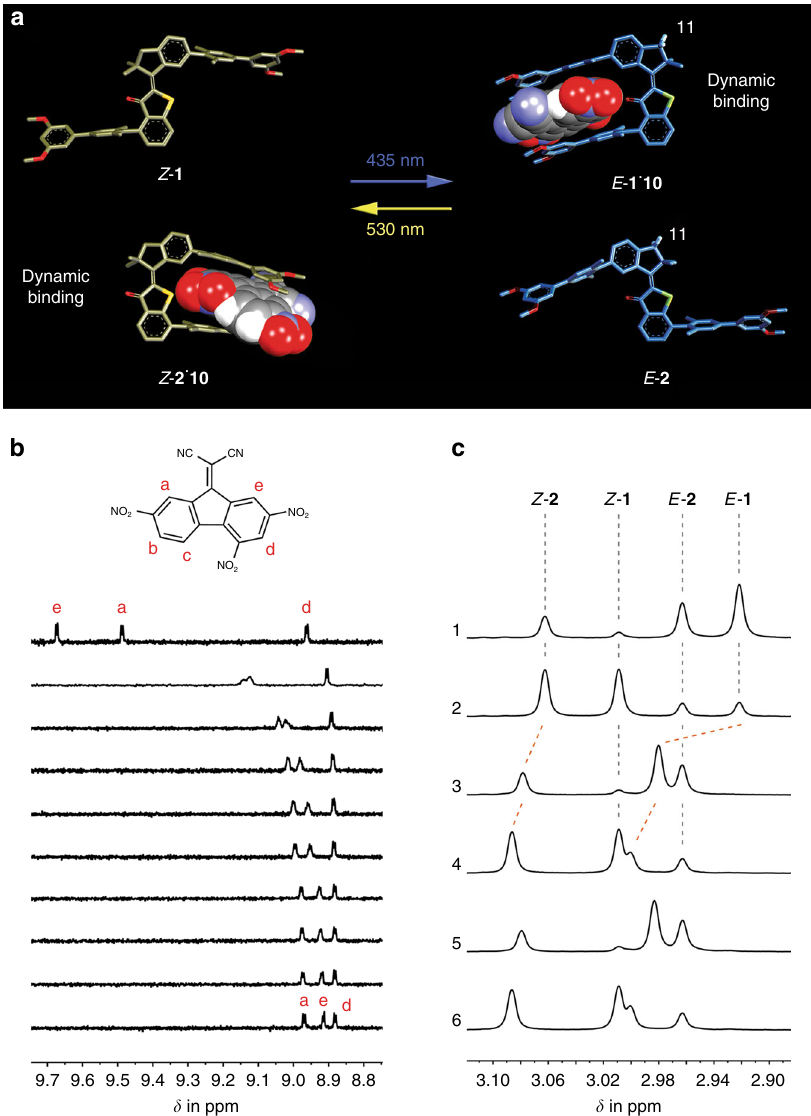
Fig. 5 Simultaneous photoswitching controls dynamic guest relocalization. a The molecular structures of tweezers 1 and 2 in different isomeric states, as well as their supramolecular complexes E - 1 . 10 and Z - 2 . 10 were obtained from quantum chemical modeling at the B3LYP/6-311 G(d,p) or B3LYP-GD3BJ/6- 311 G(d,p) level of theory, respectively. b Selected region of the 1 H NMR (400 MHz, 253 K, CDCl 3 ) spectra acquired during titration of 10 with E - 1 . Chemical shifts of the indicative protons of 10 , which change during the titration are assigned to the molecular structure of 10 . c Selected region of the 1 H NMR (400 MHz, 293 K, CDCl 3 ) spectra acquired during simultaneous complementary photoswitching and dynamic guest relocation. The isolated signals of proton 11 (marked in the molecular structures of E - 1 . 10 and E - 2 in Fig. 5a) are shown. All different molecular species are assigned. 1: Pss of the 1:1 mixture of 1 and 2 at 435 nm. 2: Pss of the 1:1 mixture of 1 and 2 at 530 nm. 3: Pss of the 1:1 mixture of 1 and 2 at 435 nm in the presence of 0.6 equiv. of 10 . 4: Pss of the 1:1 mixture of 1 and 2 at 530 nm in the presence of 0.6 equiv. of 10 . 5 and 6: Repetition of the dynamic guest relocation experiments at 435 nm